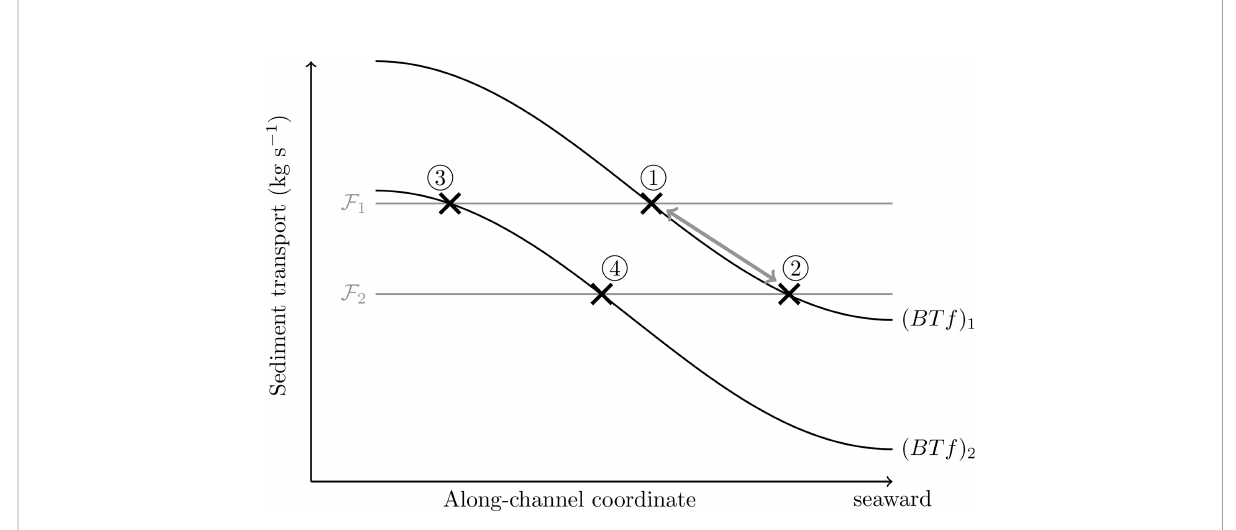
FIGURE 3 A conceptual fi gure showing the effects of changing net sediment transport F (grey) and advective transport BTf (black) on the location of sediment trapping (cross), assuming small in fl uence of net sediment transport on the